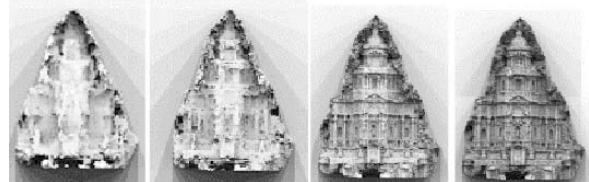
Figure 1. The multi resolution MicMac matching approach, applied on cultural asset (wooden tabernacle, XVIIth century., Piedmont)